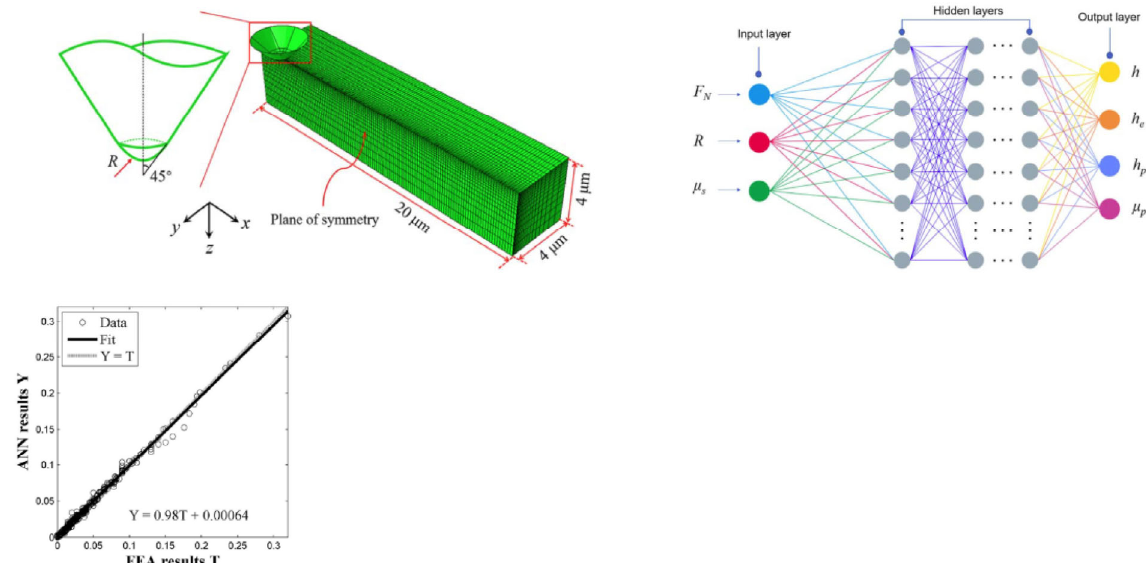
Fig. 64 FE model of scratch, ANN model for scratch simulations, and ANN training regression analysis [891]. Reproduced with permission from Ref. [891], © American Society of Mechanical Engineers,